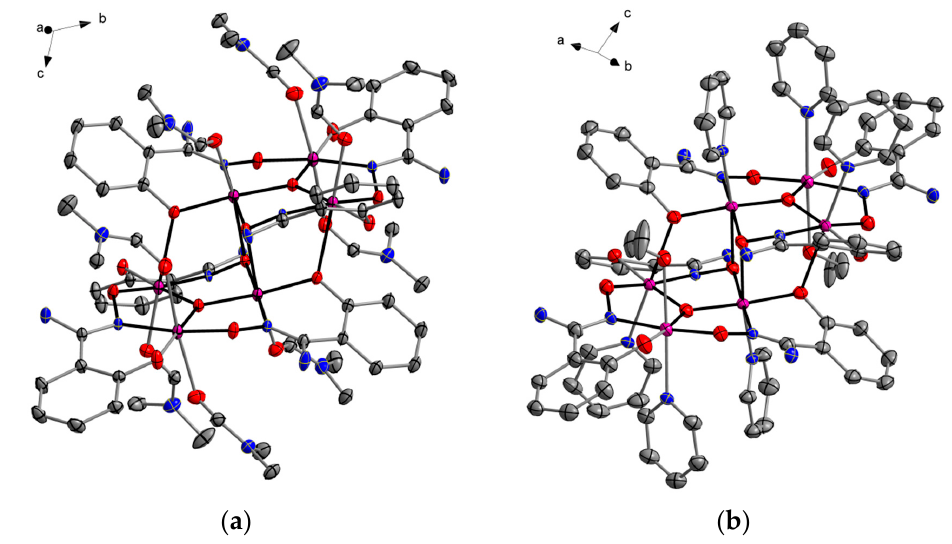
Figure 1. ( a ) Molecular structure of the [Mn 6 ( μ 3 -O) 2 (H 2 N-sao) 6 (dmf) 8 ] 2+ cation of 1 . H atoms and (ClO 4 ) − anion have been omitted for clarity. Thermal ellipsoids are depicted at 50% probability level. ( b ) Molecular structure of the [Mn 6 ( μ 3 -O) 2 (H 2 N-sao) 6 (py) 6 (EtOH) 2 ] 2+ cation of 2 . H atoms, [ReO 4 ] − anions and EtOH solvent molecules have been omitted for clarity. Thermal ellipsoids are depicted at 50% probability level. Color code: Pink, Mn; red, O; blue, N; grey, C.